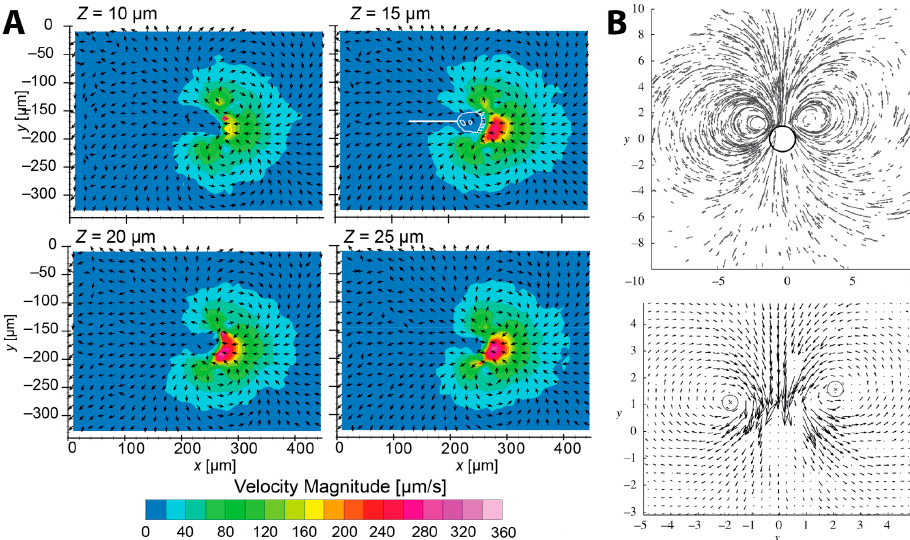
Figure 4. Feeding current of Vorticella . ( A ) μ -PIV measurements of the feeding current of V. picta (reproduced from [6]). 2D flow fields of x - and y -velocity components were measured at various z planes; ( B ) particle paths and flow field obtained from the feeding current of V. convallaria shown in Figure 1B. The circle in the top figure represents the zooid, and the two circles in the bottom figure show the center of eddies (reproduced from [8]).